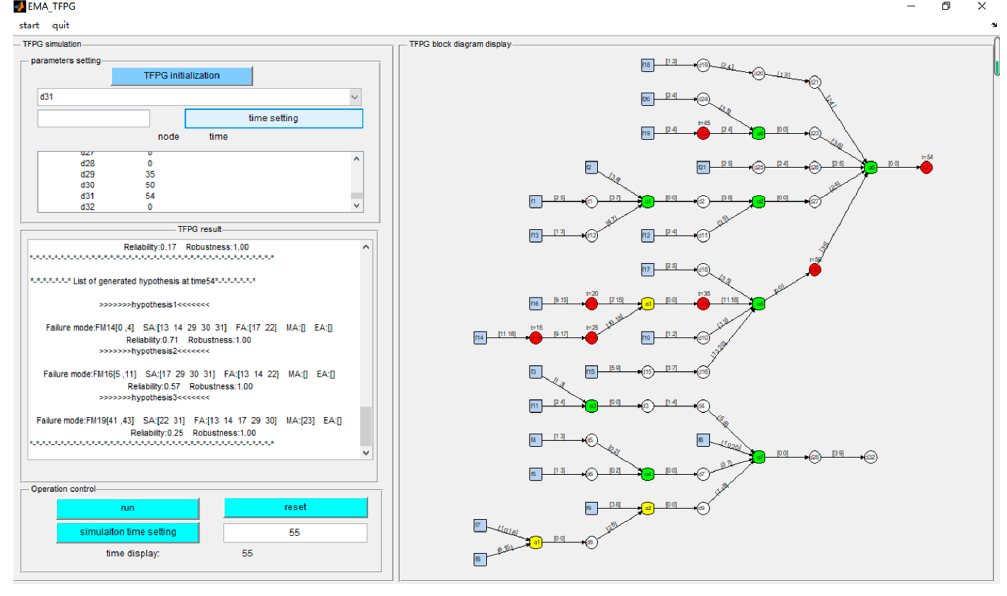
Figure 9. Simulation settings. Table 2. Simulation results based on the improved